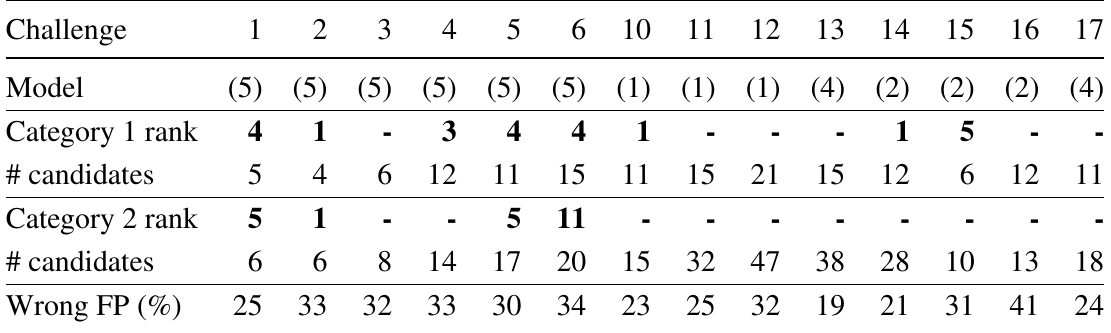
Table 2. Absolute ranks of the correct molecules in the solution lists for the challenges in Category 1 and 2 and the number of candidates. Challenges where the correct molecule is not in the result list are marked with “-” instead. The model used for each challenge to predict the fingerprints is listed in the Model row. The proportions of wrongly predicted molecular fingerprints are shown in the last row.